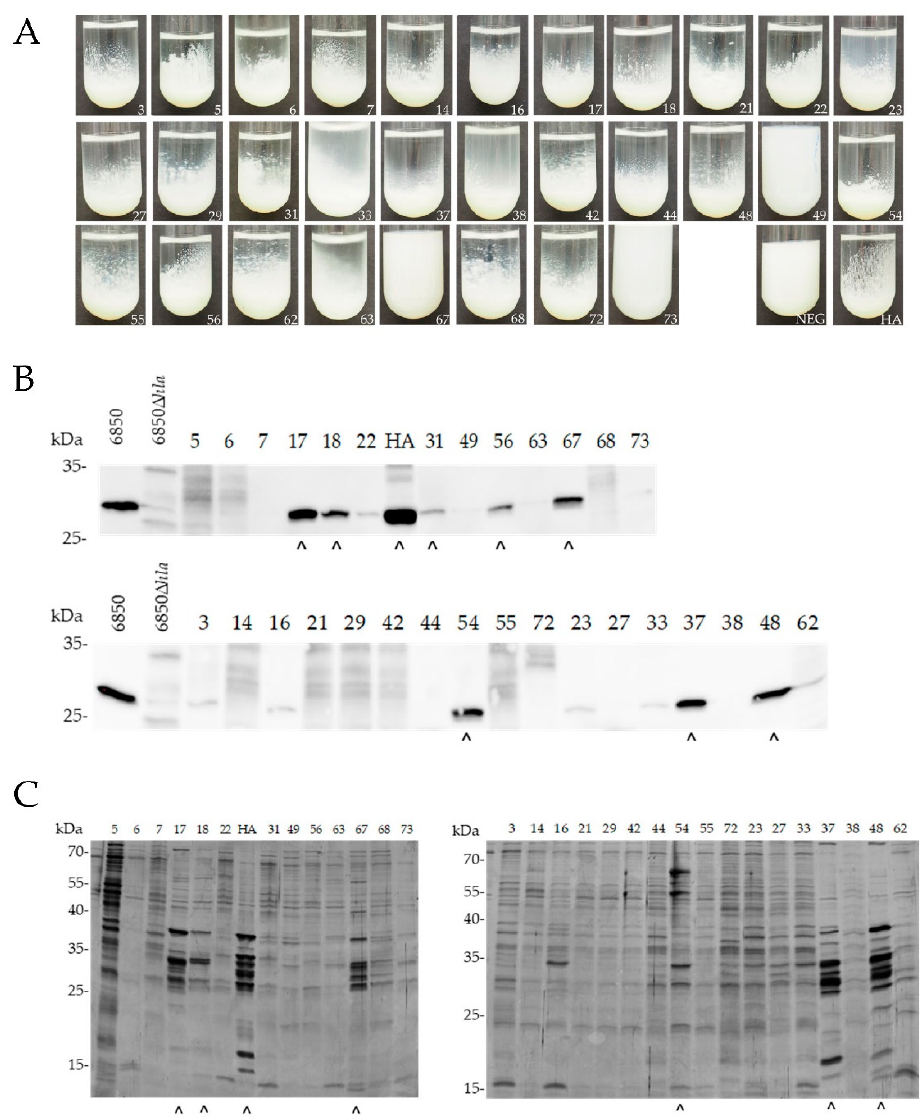
Figure 2. Phenotypic screening of SigB deficiency of non-/intermediate-pigmented mastitis-derived isolates (n = 30). ( A ) Proteolysis in skim milk. Isolates were grown in 1% skim milk and proteolysis was assessed after 24 h. ( B , C ) Western blot against Hla ( B ) and SDS-PAGE of bacterial secretion pattern ( C ) were performed from supernatants derived from equal numbers of S. aureus cells harvested at OD 600 = 5. HA, reference strain; NEG, negative control. (ˆ) Strains, positive for Hla secretion and increased protein secretion.